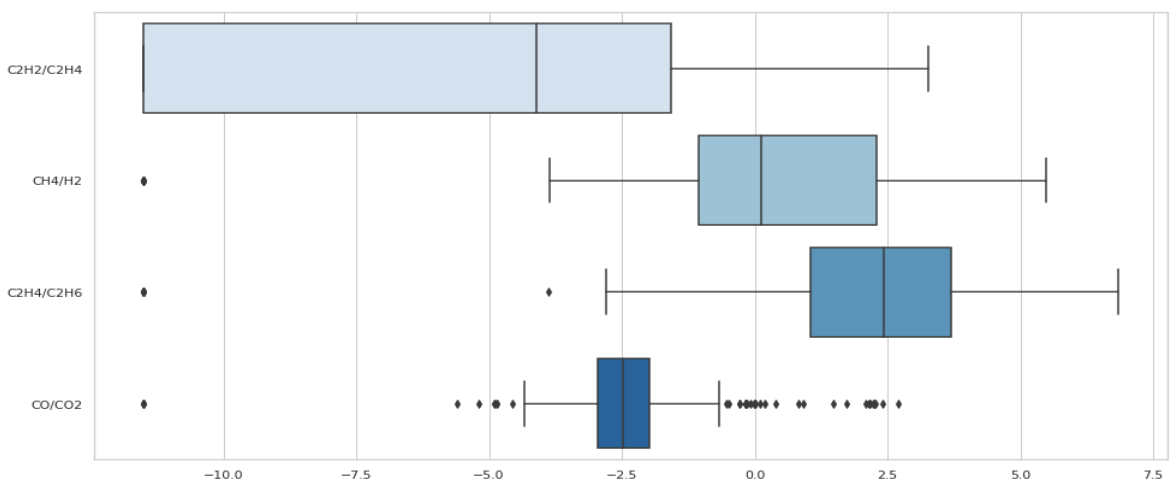
Figure 12. Box plot of ratios of the dissolved gas concentrations after applying the logarithmic trans- formation.